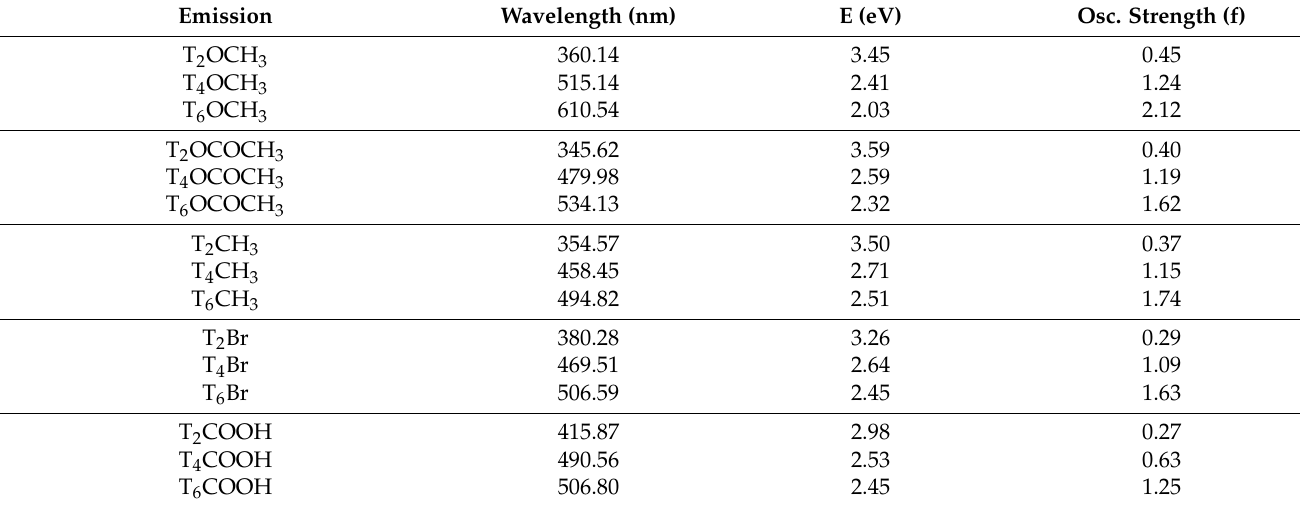
Table 6. Wavelengths of highest peaks of emission spectra of derivatives of T2, T4, and